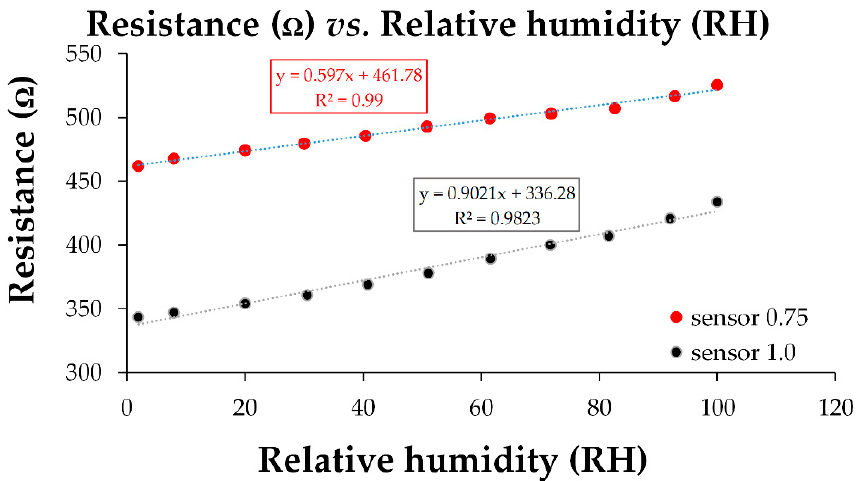
Figure 9. The transfer function of the quaternary nanohybrid-based resistive sensors in humid nitrogen (RH = 0–100%).